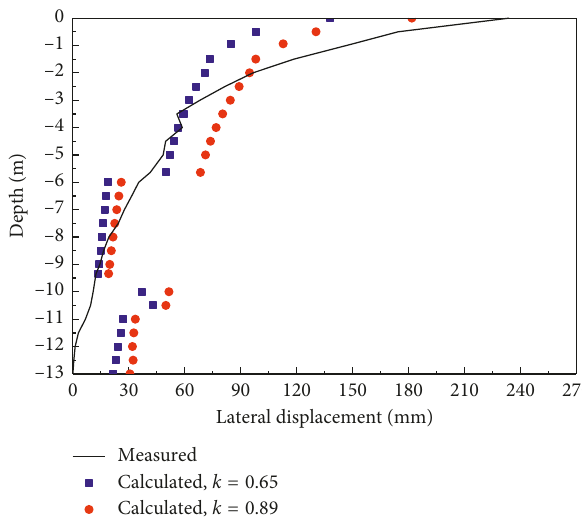
Figure 10: Lateral displacement at a distance of 10m from Section 2